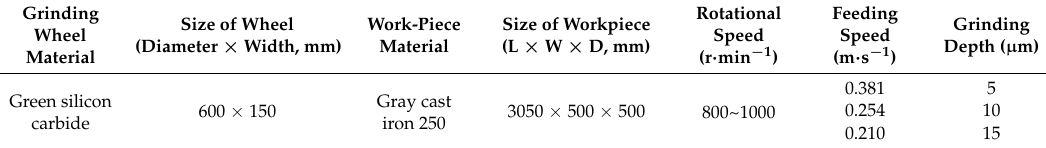
Figure 11. ( a ) CNC guideway grinder KD4020X16; ( b ) TST5912 analysis system.